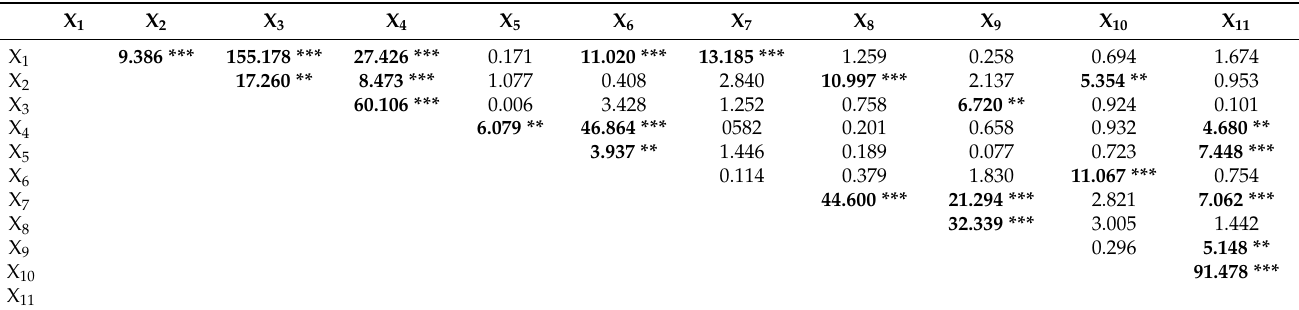
Table 5. Bivariate correlation results between household characteristics.